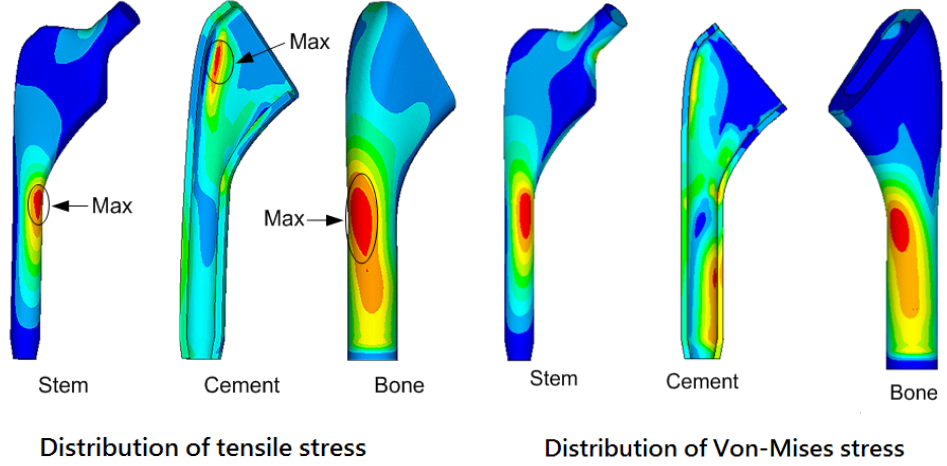
Figure 7. Distributions of maximum tensile stress and Von-Mises stress within stem, cement and femur bone.